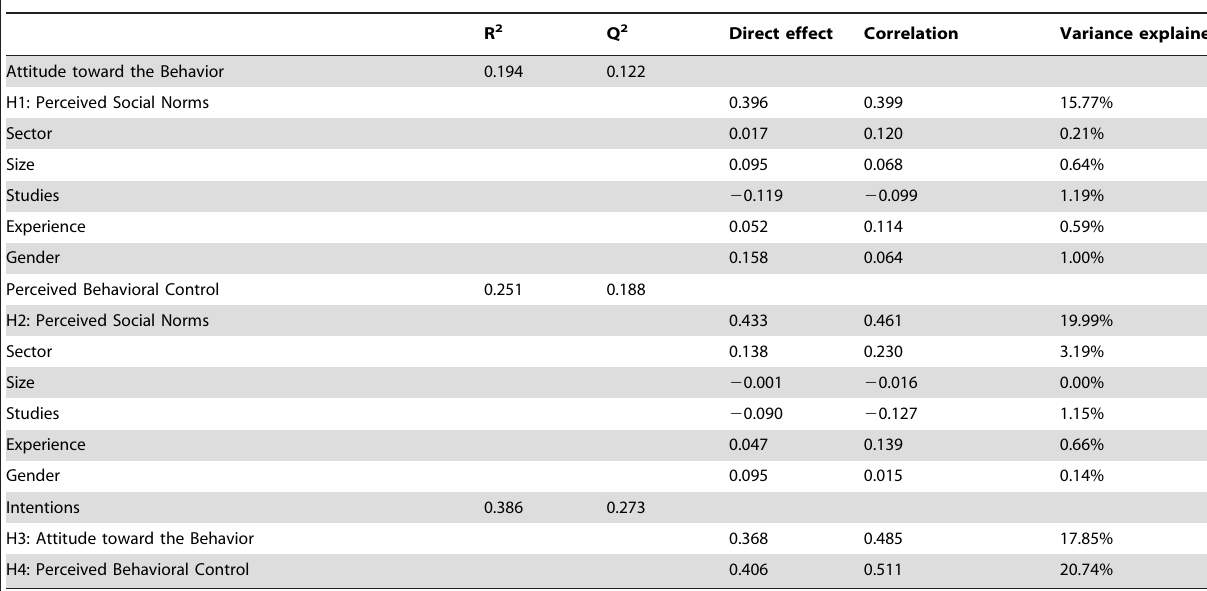
Table 5. Effects on endogenous variables.